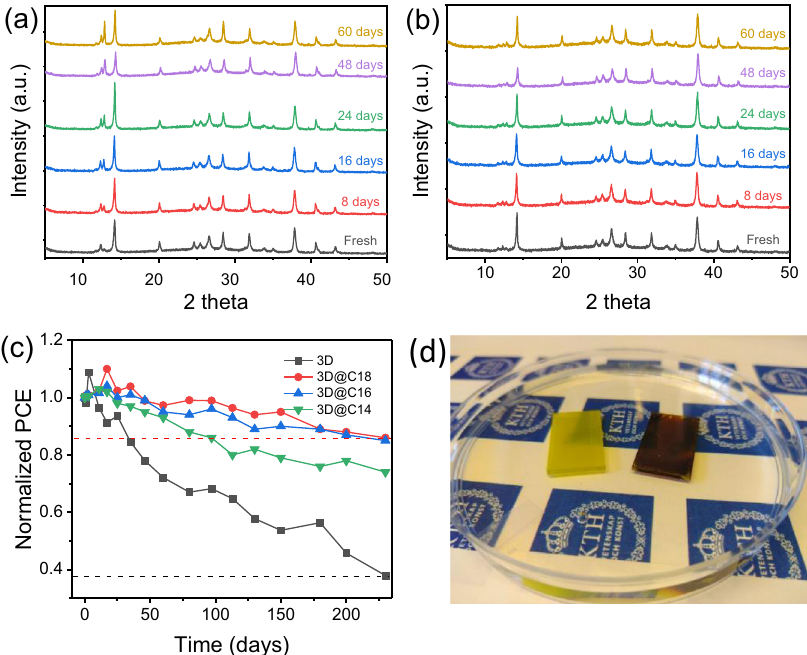
Fig. 5 Environmental and water stability. XRD patterns of ( a ) 3D-only and ( b ) 3D@C18 thin fi lms illustrating the evolution of degradation in 3D-only perovskite thin fi lms and 2D perovskite prevents this degradation when monitored over a period of two months and stored under an ambient atmosphere with a relative humidity of 25-80%. c Variation in PCE of nonencapsulated 3D-only PSCs and C14, C16, and C18 perovskite-coated PSCs kept under ambient atmosphere (RH 25 – 80%, 10 – 25 °C, in the dark). d Photograph of 3D-only (on the left) and C18 perovskite-coated 3D perovskite (on the right) thin fi lms after immersion in water for 3